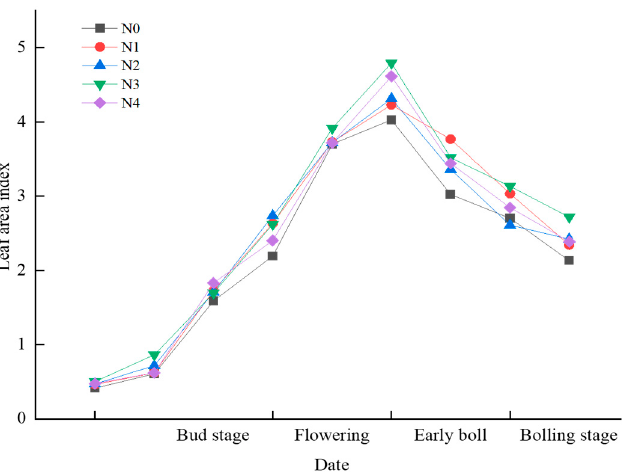
Figure 2. Changes in the leaf area index (LAI) of cotton measured under different nitrogen fertilization treatments. NO: 0 kg ha − 1 ; N1: 120 kg ha − 1 (severely deficient in fertilizer); N2: 240 kg ha − 1 (slightly deficient in fertilizer); N3: 360 kg ha − 1 (moderate fertilization); N4: 480 kg ha − 1 (over-fertilization).